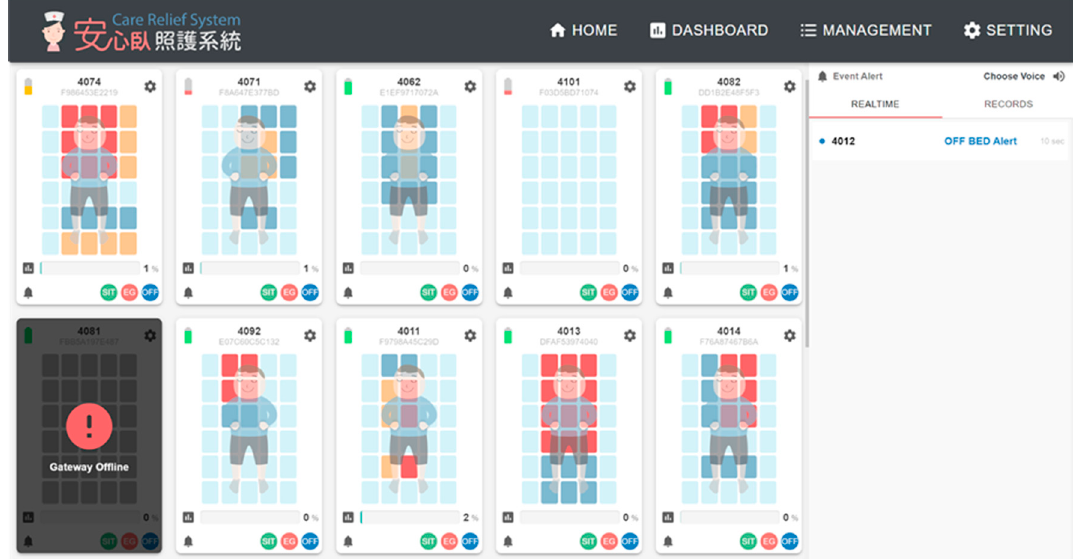
Figure 11. The screen displayed at the nursing station for the real-time status of the residents.